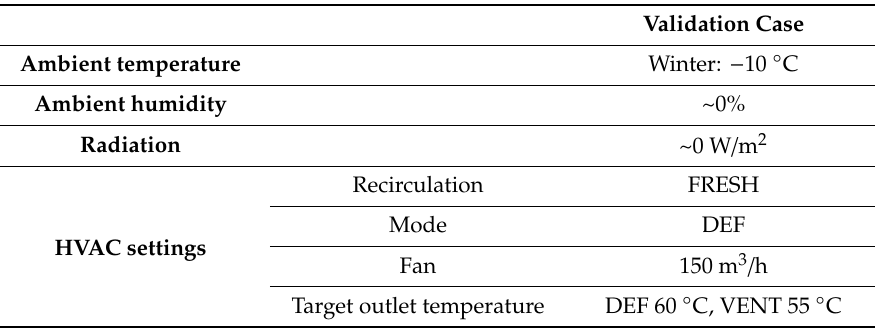
Table 3. Validation case for the 1D thermal and comfort models.